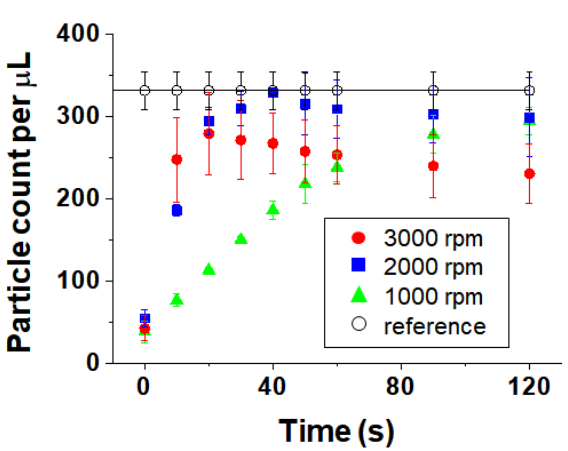
Figure 8. Particle counts depending on time at different spin speeds (1000, 2000 and 3000 rpm).